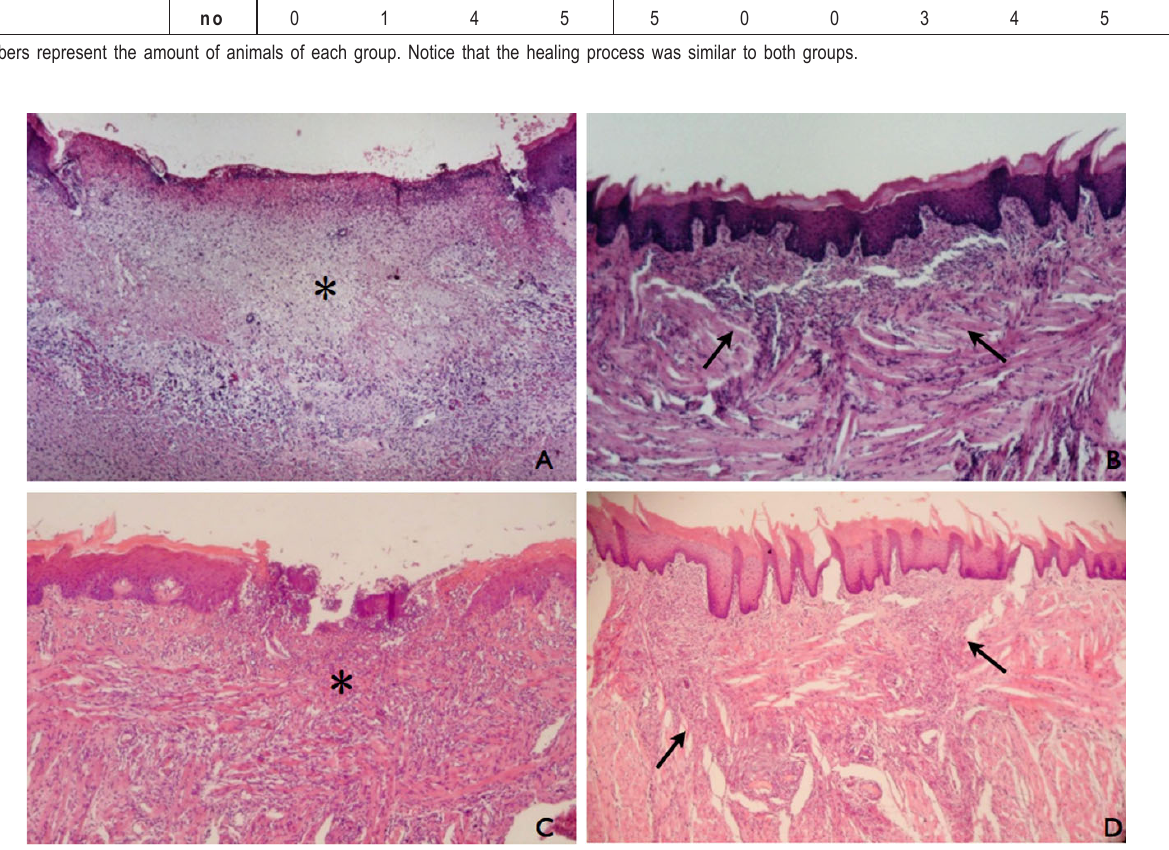
Fig. 1. Comparison of histological features of healing in control group and Papacarie TM group. A: lingual mucosa of rat from control group on day 3, with ulceration, inflammation and edema (*); B: healing process on day 7, with complete reepithelization, formation of epithelial ridges and granulation tissue (arrows); C and D: Papacarie TM group on days 3 and 7, respectively, with similar histological features (hematoxylin-eosin; original magnification: 100x)